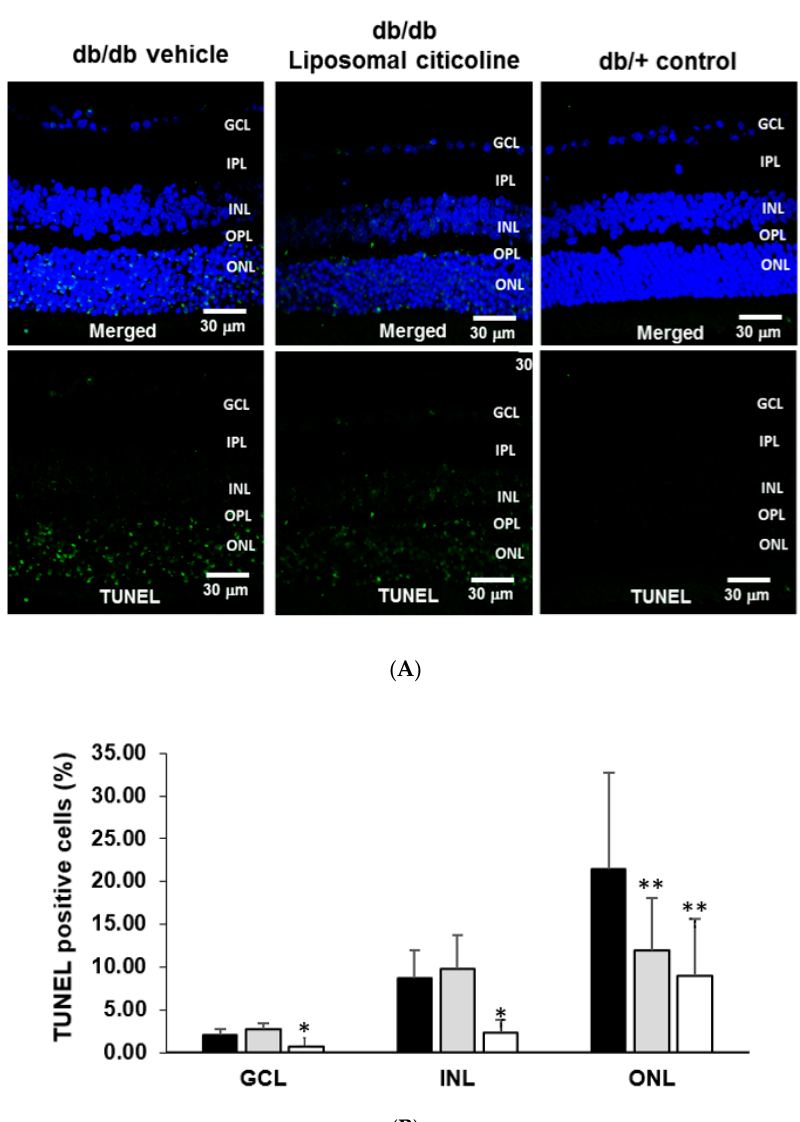
Figure 3. Effect of citicoline on apoptosis. ( A ) TUNEL (Terminal Transferase dUTP Nick ‐ End Labeling) positive immunofluorescence (green) in a representative mouse from each group. Nuclei were labeled with Hoechst (blue). Scale bars, 30 μ m; ( B ) percentage of TUNEL positive cells in the neuroretina. ONL: outer nuclear layer; INL: inner nuclear layer; GCL: ganglion cell layer. Black columns: db/db ‐ vehicle; gray columns: db/db ‐ citicoline; white columns: db/+. Results are mean ± SD. *: p < 0.05 in comparison with the other groups. **: p < 0.05 in comparison with db/db ‐ vehicle. n = seven mice per group.